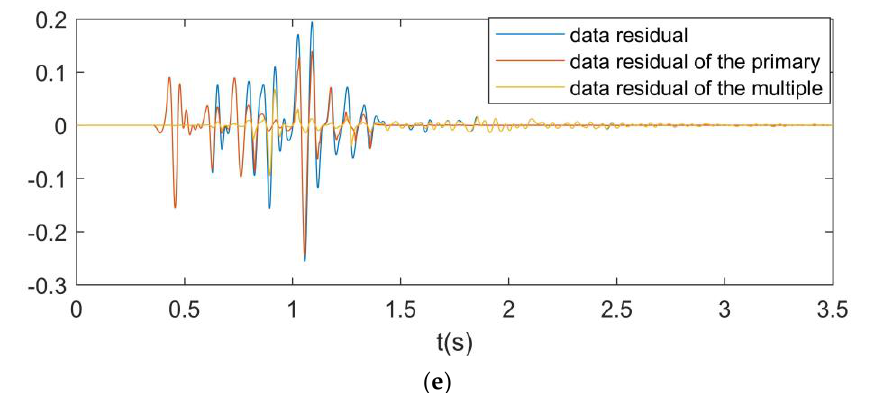
Figure 7. ( a ) Recorded data. ( b ) Predicted internal multiples after five iterations. ( c ) The primary of data residual after using the weighting matrix. ( d ) The internal multiple of data residual after using the weighting matrix. ( e ) Waveform comparison of data residual and data residual of primary and internal multiple.